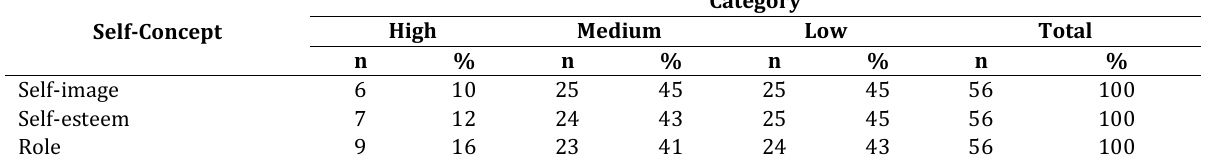
Table 4. Self-Concept in Leprosy Patients in Probolinggo